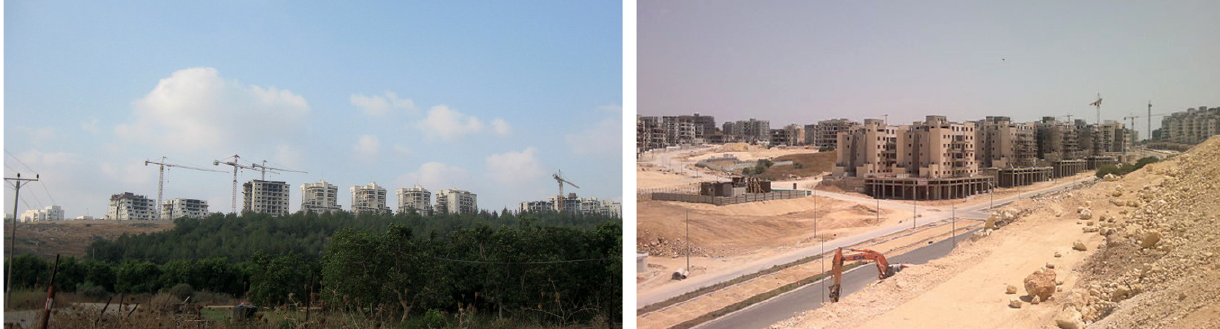
Figure 10. Left: Tzur‐Yitzhak, 2010. Right: Harish, 2016. Source: Wikimedia